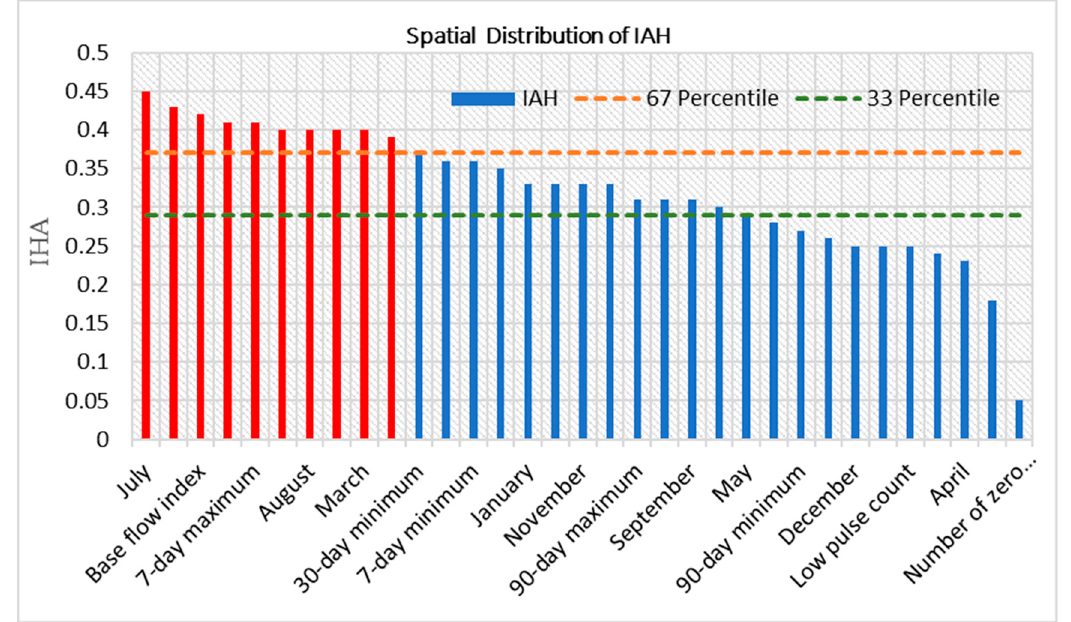
Figure 7. Hydrological Alteration of Group − 5 indicators.